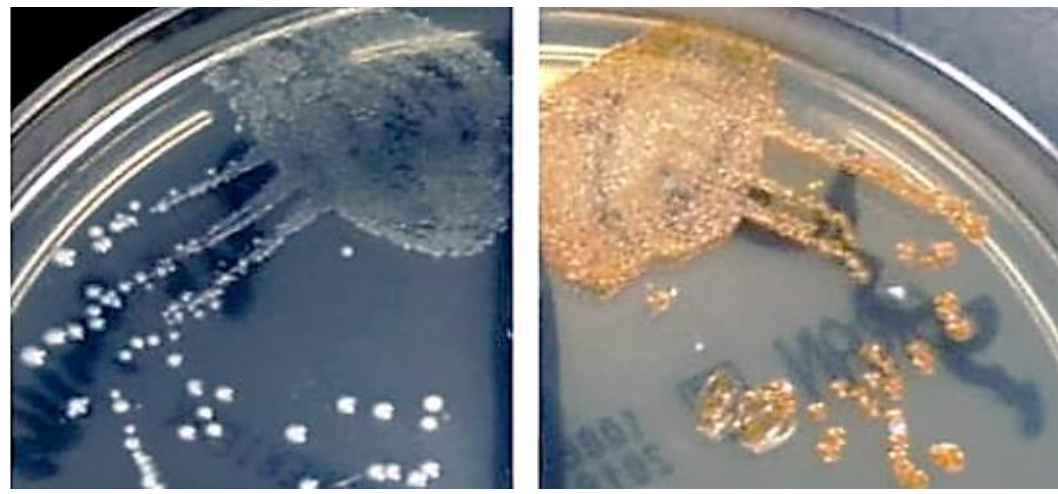
Figure 2. Granada agar showing the orange colonies characteristic of positive Streptococcus agalactiae on the right side of the plate. The white colonies on the left side indicates negative for Streptococcus